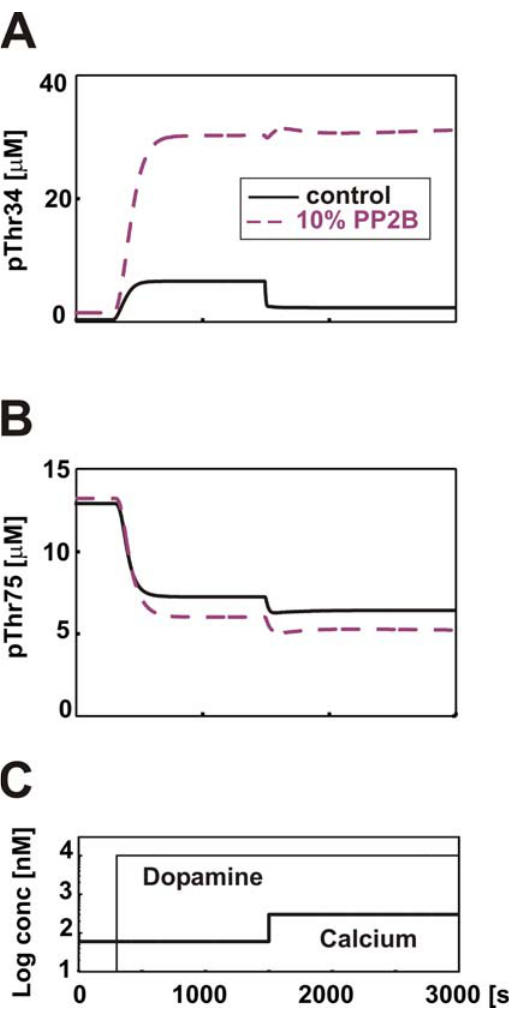
Figure 3. Simulations of Prolonged D 1 Receptor Stimulation Paired with Calcium Elevation (A) Dopamine-dependent increase in phosphoThr34 starting at time 300 s is reduced when, in addition, calcium is elevated at time 1500 s (solid line). (B) Dopamine-dependent decrease in phosphoThr75 is minimally changed by a subsequent calcium elevation. Reduction of PP2B activity increases the levels of phosphoThr34 and abolishes the calcium- dependent decrease in phosphoThr34 (A, purple dashed line). Further- more, inhibition of PP2B activity indirectly decreases the levels of phosphoThr75 (B, purple dashed line) because less DARPP-32 is available for phosphorylation on Thr75 since more of it is phosphorylated on Thr34. (C) Time course of dopamine and calcium elevation. DOI: 10.1371/journal.pcbi.0020119.g003